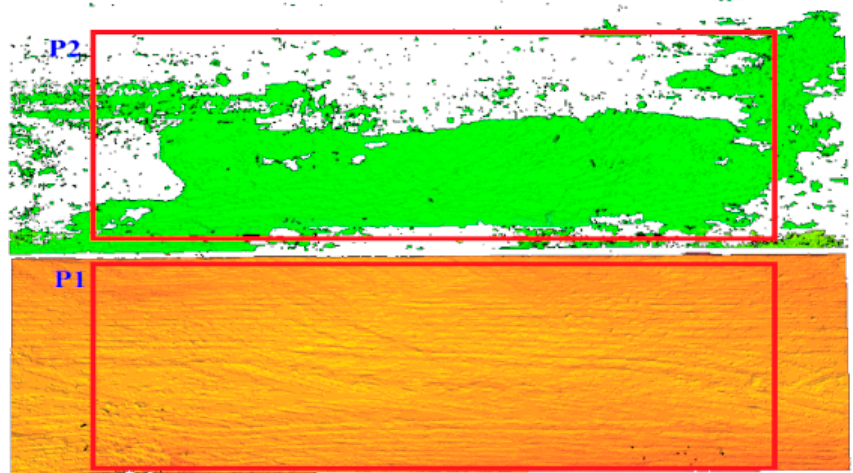
Figure 10. Definition of the measurement area P1 and P2 in the uninfected and infected area.